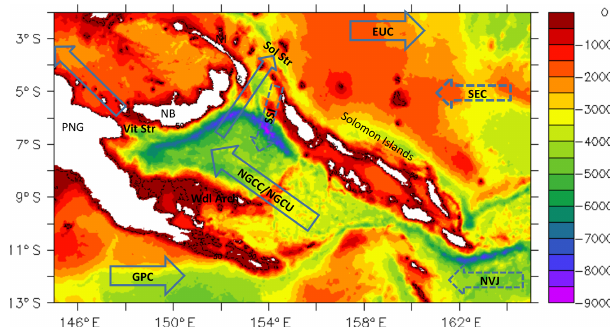
Figure 1. Bathymetry of the Solomon Sea over the domain of the re- gional simulation (in color; units: meters, m). The depth of 50m has a black contour. PNG: Papua New Guinea; NB: New Britain; NI: New Ireland; Vit. Str.: Vitiaz Strait; Sol. Str.: Solomon Strait; Wdl arch.: Woodlark archipelago. The arrows illustrate the different cur- rents mentioned in the text (dashed arrows are for surface currents, line arrows are for the thermocline currents). NGCC: New Guinea Coastal Current; NGCU: New Guinea Coastal Undercurrent; SSI: Solomon Strait inflow; EUC: Equatorial Undercurrent; SEC: South Equatorial Current; NVJ: North Vanuatu Jet; GPC: Gulf of Papua Current. The bathymetric file is the NOAA/ETOPO2v2 bathymetric file from the Smith & Sandwell database (https://doi.org/10.7289/ V5J1012Q, National Geophysical Data Center,